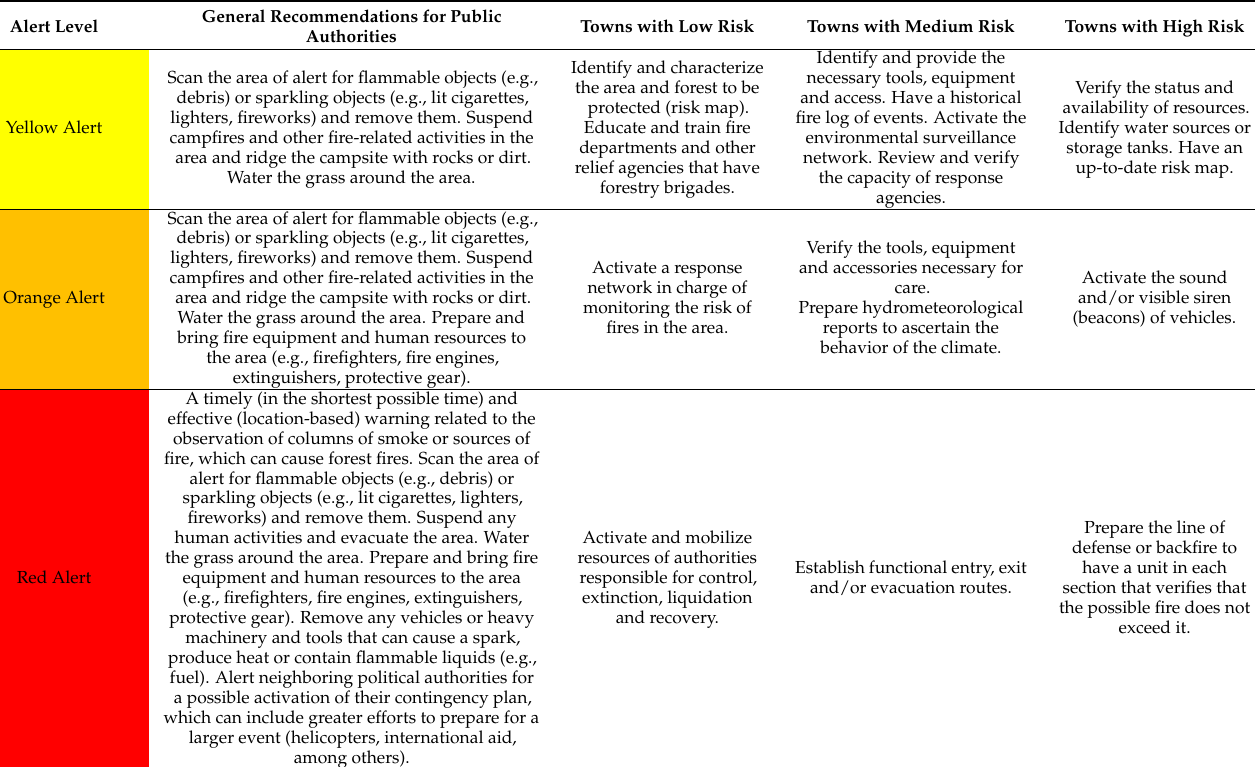
Table 3. General Protocol for public authorities in the case of a fire alert 24 h